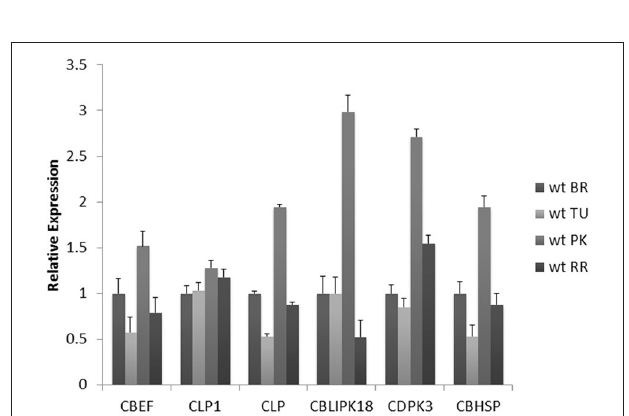
FIGURE 6 | Expression analysis of Calcium-binding EF (CBEF), Calmodulin-like protein 1 (CLP1), Calmodulin-like protein (CLP), CBL-interacting protein kinase 18 (CBLPK18), Calcium dependent protein kinase 3 (CDPK3), Calmodulin-binding heat-shock protein (CBHSP) genes in different fruit ripening stages of Breaker (BR), Turning (TU), Pink (PK) and Red Ripe (RR) of wild-type Ailsa-Craig ( Solanum Lycopersicum ). Relative fold changes were calculated based on the comparative Ct method, using actin as an internal standard. The Ct value for each gene was normalized to the Ct value for actin and was calculated relative to a calibrator (Breaker) using the formula 2_DDCt. Vertical bars are the average S.E. of three biological replicates. Microarray fold-changes are estimated in relation to the Breaker stage.